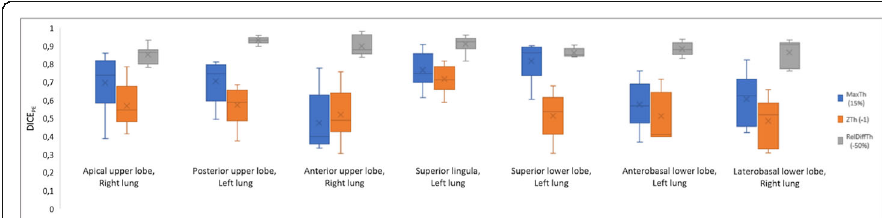
Fig. 5 Influence of PE location: high DICE PE were found using the RelDiff method regardless of the location of PE